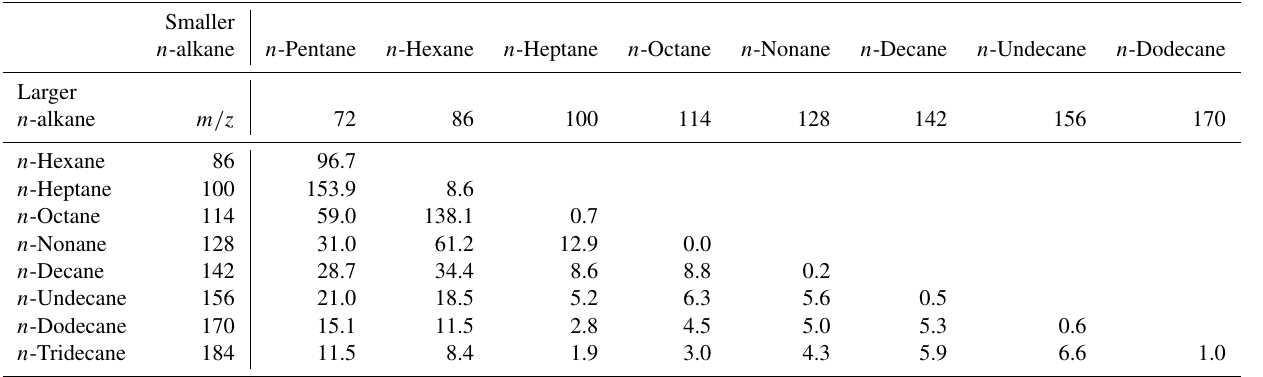
Table 3. Fragment contribution distribution (FCD, %) from larger n -alkanes to smaller n -alkanes.